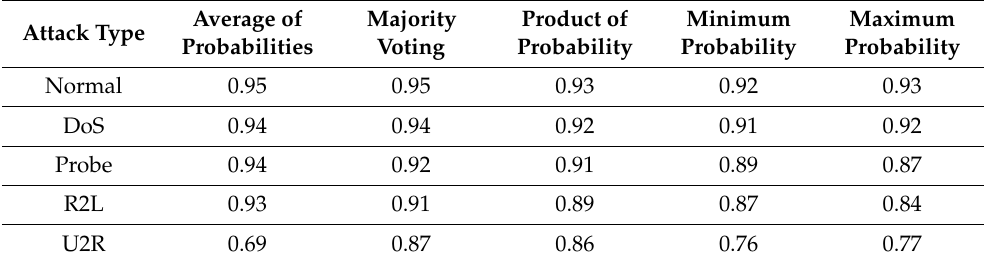
Figure 13. Specificity performance of confusion matrix.